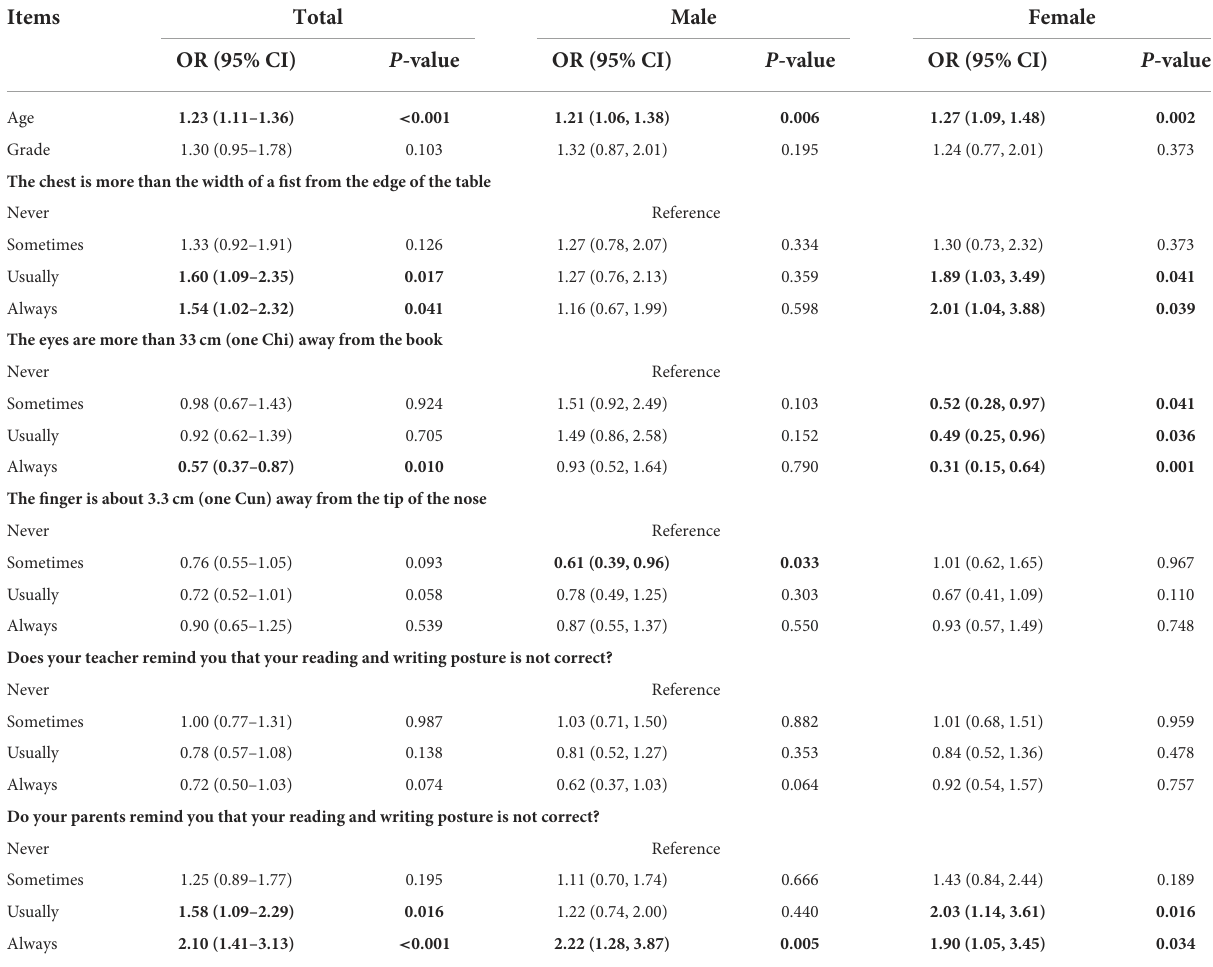
TABLE 2 Logistic regression of myopia-related factors by